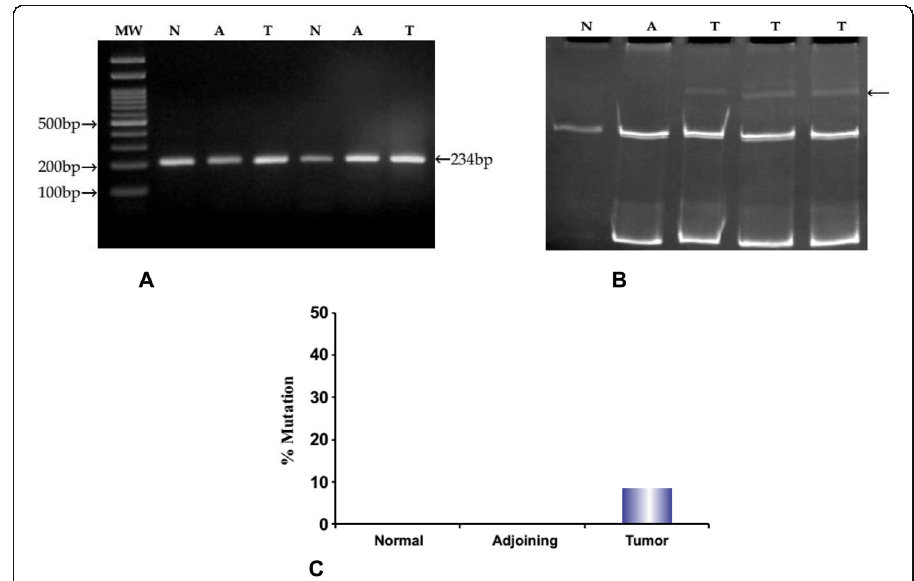
Fig. 1 Mutation detection in exon 1 of TCF-4 gene by PCR amplification and SSCP analysis. a shows agarose gel electrophoresis of PCR product of exon 1 of TCF-4 gene from 2 representative cases of CRC (N: normal tissue, A: adjoining tissue, T: tumor tissue). MW: molecular weight marker (100bp DNA ladder). Arrow represents the amplified PCR product of 234bp. b shows SSCP analysis of PCR product of exon 1 of TCF-4 gene. Gel picture shows the representative image of the three samples that demonstrates the band shift. Arrow represents the bands showing mobility shift in tumor tissues compared to adjoining and normal tissues. c shows the percentage of mutations in exon 1 of TCF-4 gene in tumor tissues compared to adjoining and normal